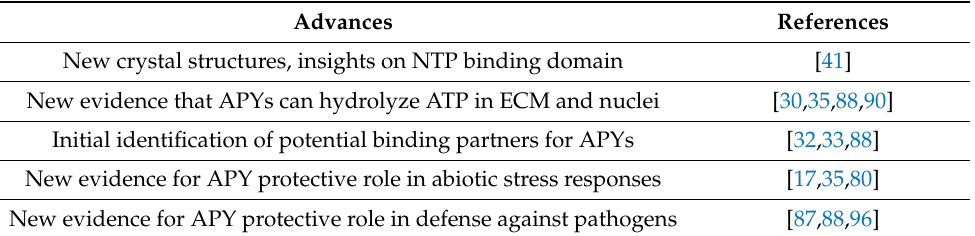
Table 1. Key recent advances in research on plant APYs